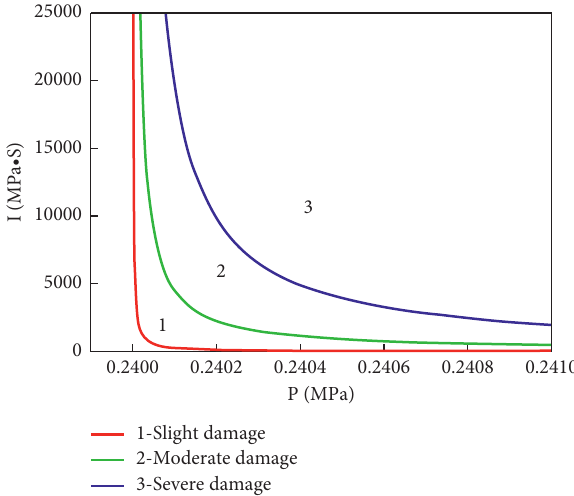
Figure 2: Damage curve of 1.5 m thick brick seal